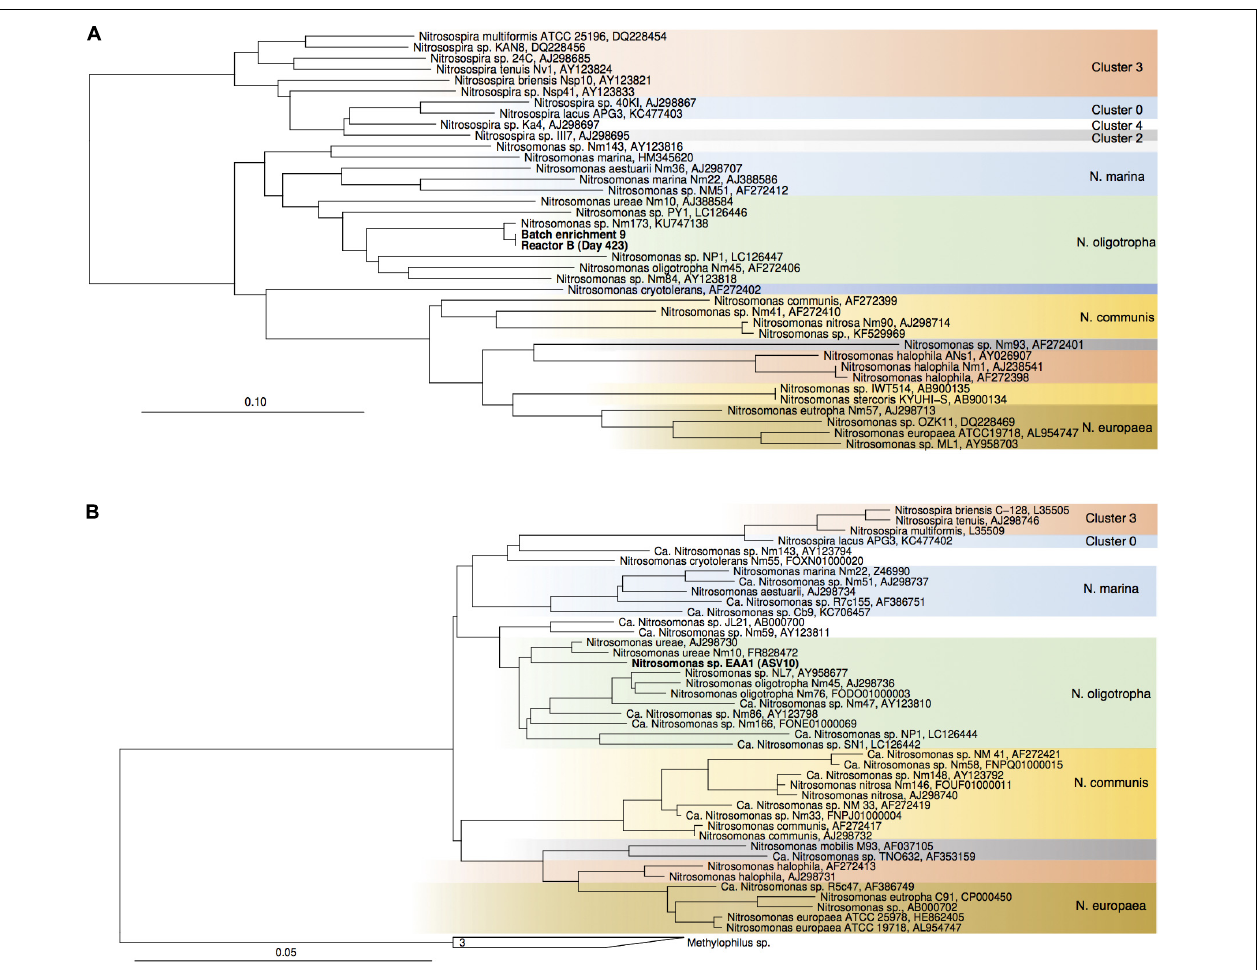
FIGURE 5 | Maximum-likelihood phylogenetic tree of proteobacterial amoA gene sequences (A) and 16S rRNA genes of Nitrosomonadaceae -affiliated AOB (B) . Sequences from the current study are highlighted in bold. Nitrosococcus - and Methylophilaceae -affiliated sequences were used as outgroups, respectively. Color codes highlight Nitrosospira sp. clusters and Nitrosomonas